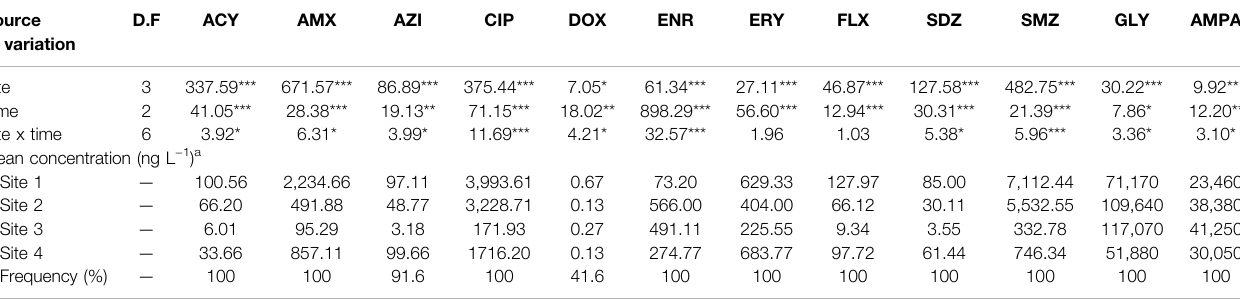
a Mean of concentration found overtime ( n (cid:2) 9). D.F., degrees of freedom. *, **, *** Signi fi cant at 0.05, 0.01 and 0.001, respectively. RSD, relative standard deviation. Acyclovir (ACY), amoxicillin (AMX), aminomethylphosphonic acid (AMPA), azithromycin (AZI), cipro fl oxacin (CIP), doxycycline (DOX), enro fl oxacin (ENR), erythromycin (ERY), fl uoxetine (FLX), glyphosate (GLY), sulfadiazine (SDZ) and sulfamethoxazole (SMZ).